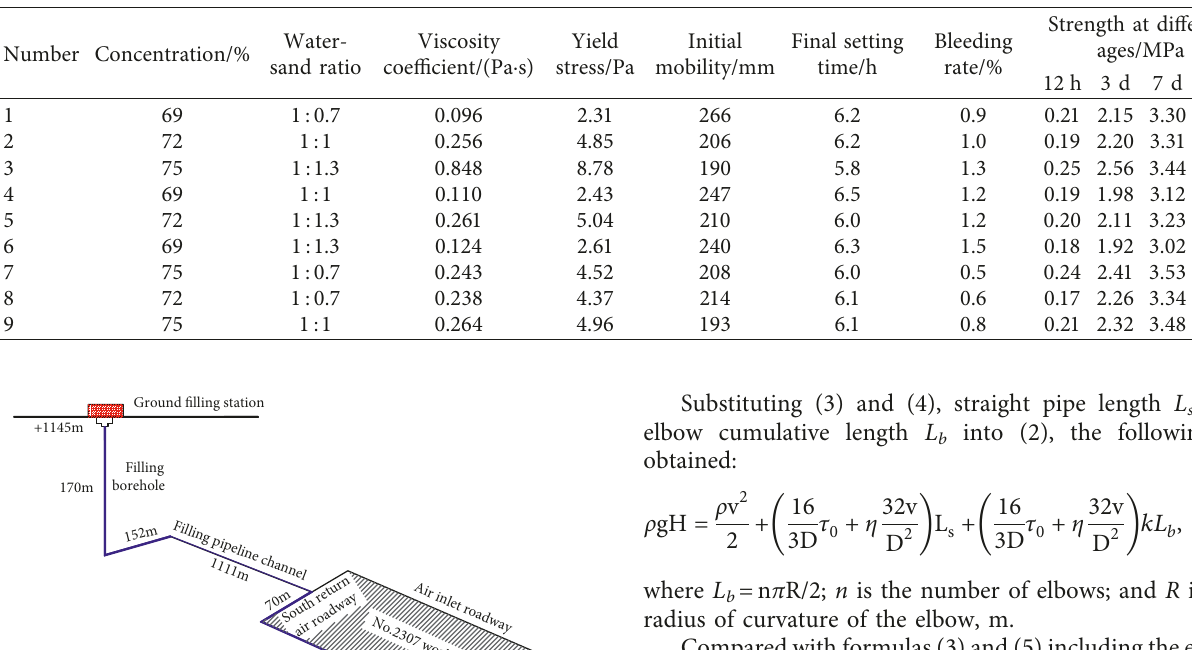
Table 1: Experimental results of backfill material proportioning.